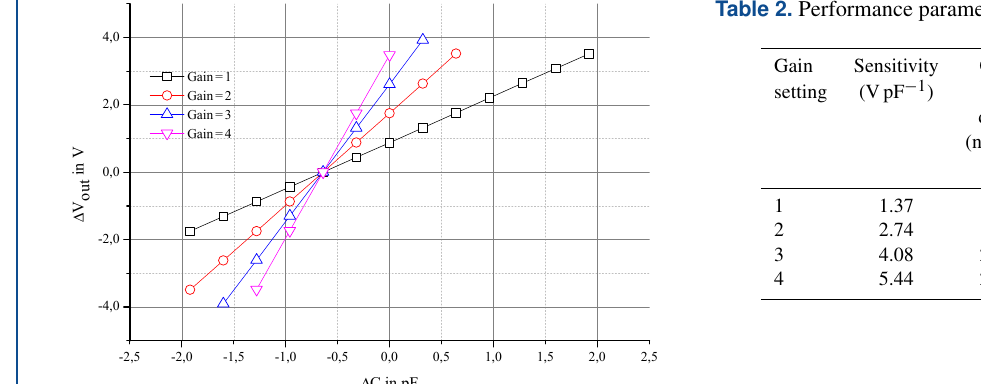
Table 2. Performance parameters of the developed